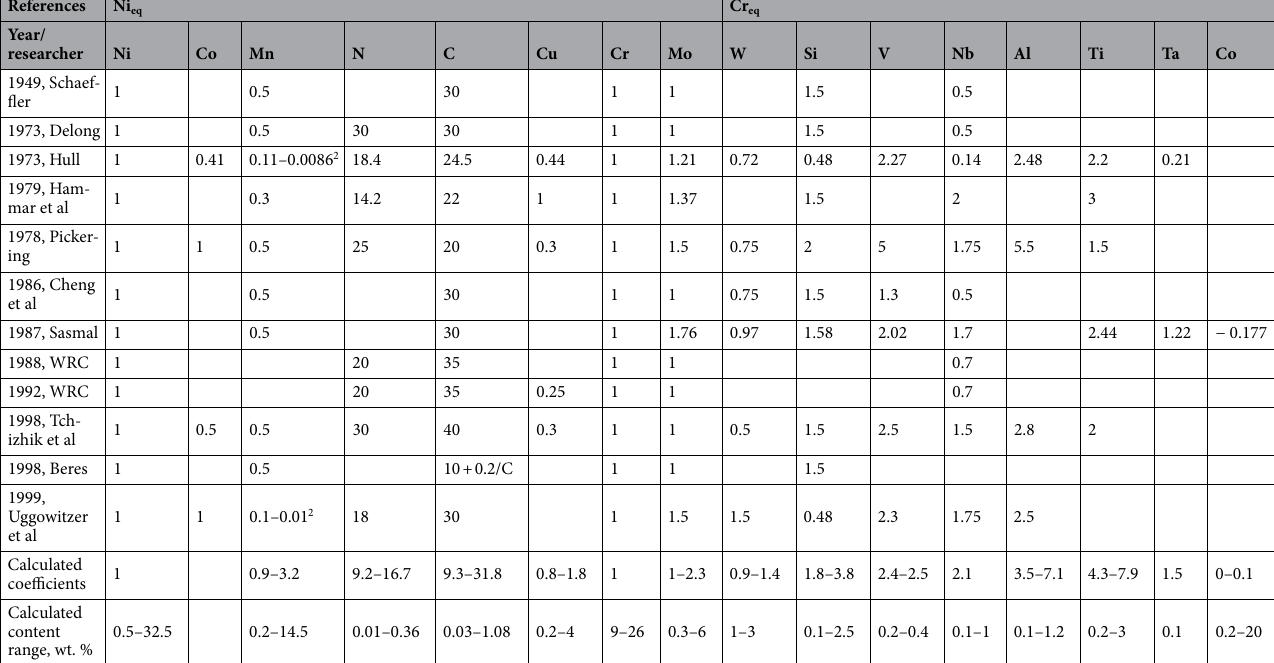
Table 1. A summary of coefficient of each element in Ni/Cr equivalents referring to literature 1–11 , and last two lines provide the range of our calculated coefficients and of the corresponding